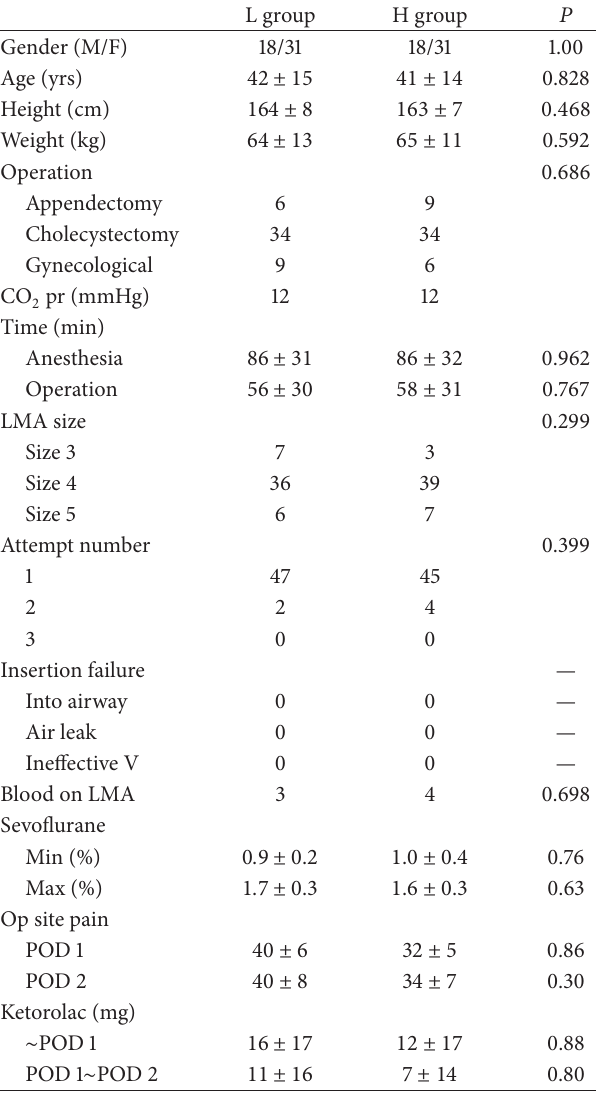
Table 1: Demographic data.